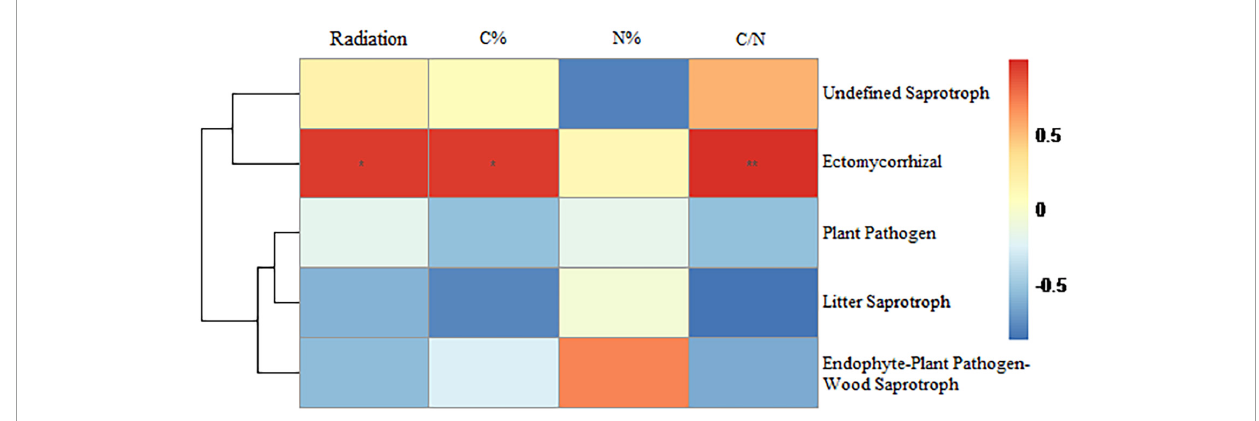
FIGURE9 Relationships between bacterial functional taxa and radiation intensity, carbon content, nitrogen content, and C/N ratio. The lines represent the relationships from cluster analysis of species/OTUs. Color depth represents the level of correlation. Significance: * < 0.05; ** < 0.01. Distance algorithm: Bray-Curtis, clustering method: Pearson.